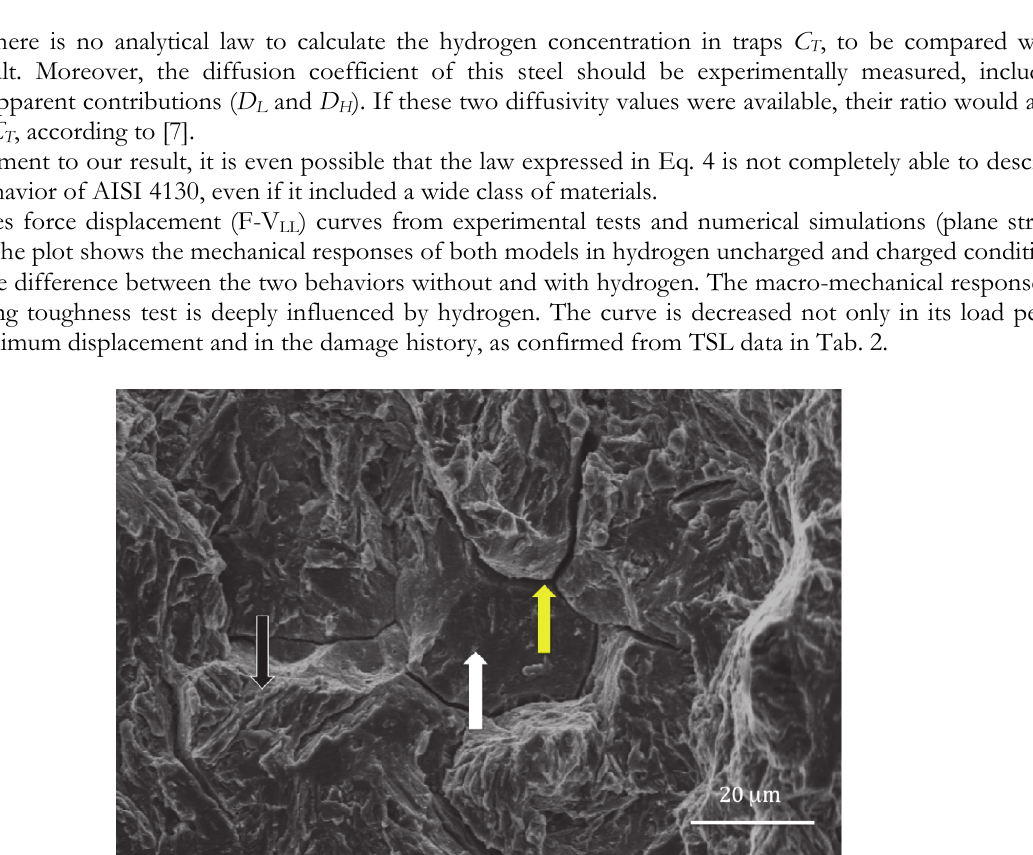
Figure 4: Contours of k (Eq.6) at crack tip region (continuum elements), plane strain model.